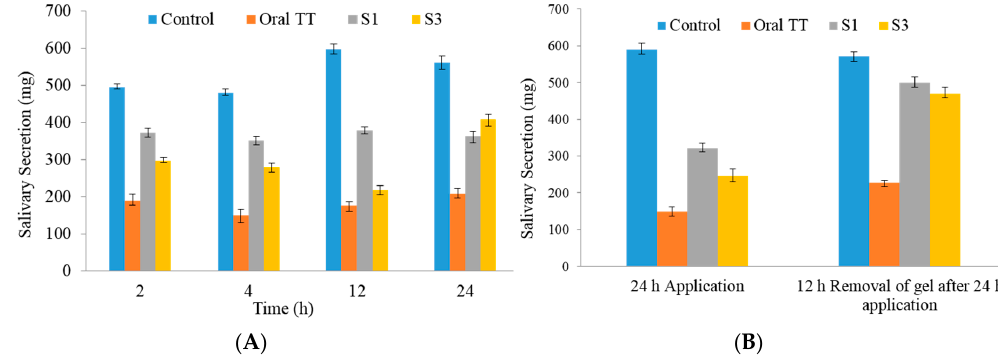
Figure 6. Salivary secretion in rats with various formulations over 24 h ( A ) control (no tolterodine tartrate (TT) treatment) compared with oral, S1, and S3 TT formulations; ( B ) Recovery of pilocarpine-induced salivary secretion after removal of gel formulation. n = 6.